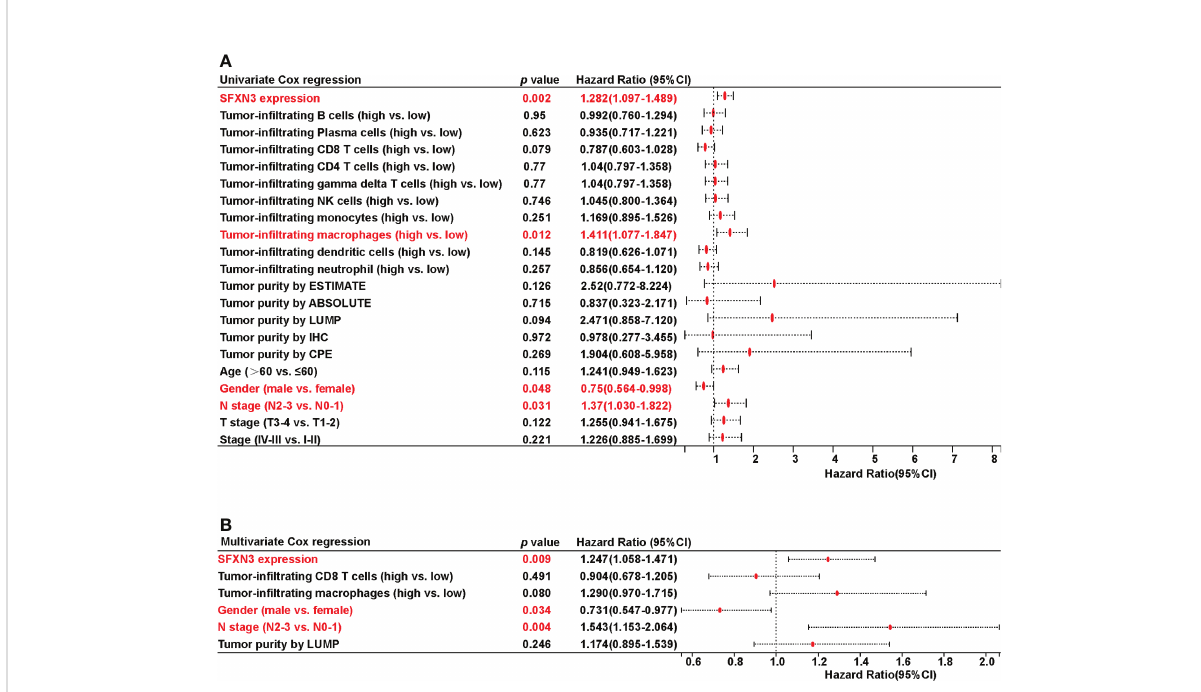
FIGURE 4 Univariate and multivariate Cox regression analyses on survival in patients with head and neck squamous cell carcinoma (HNSC). (A) Univariate Cox regression analysis on survival in HNSC. (B) Multivariate Cox regression analysis on survival in